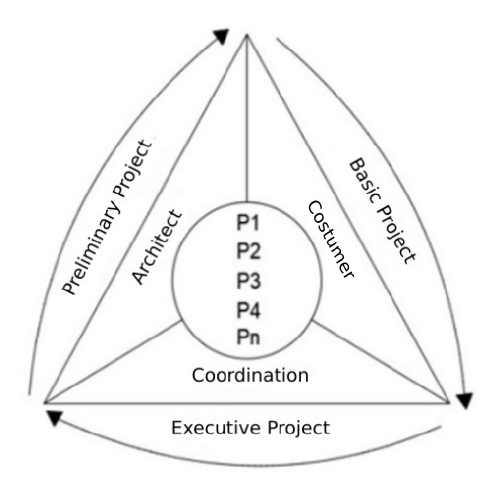
Figure 8. Integration